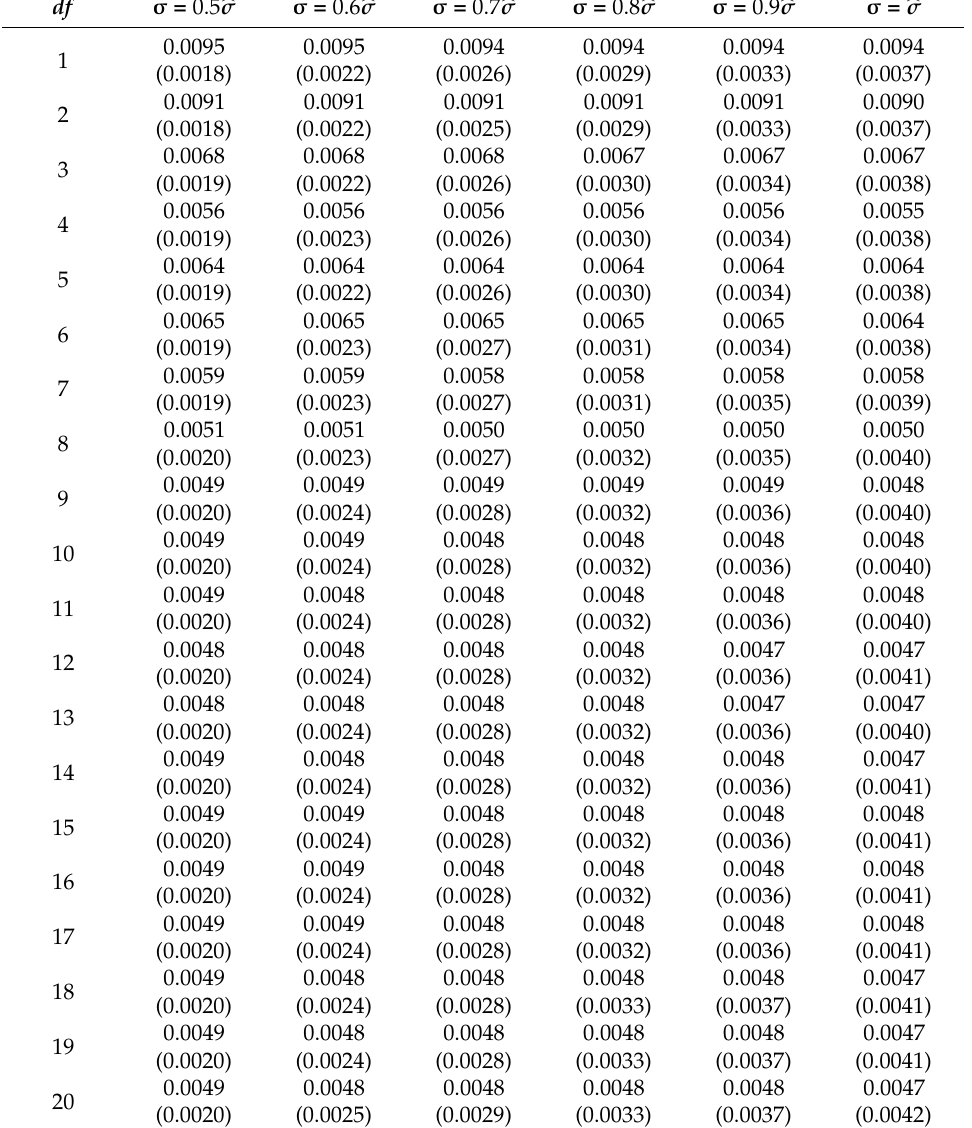
Table 3. Mean (SD) of estimated (cid:98) β 1 s derived from frequentist